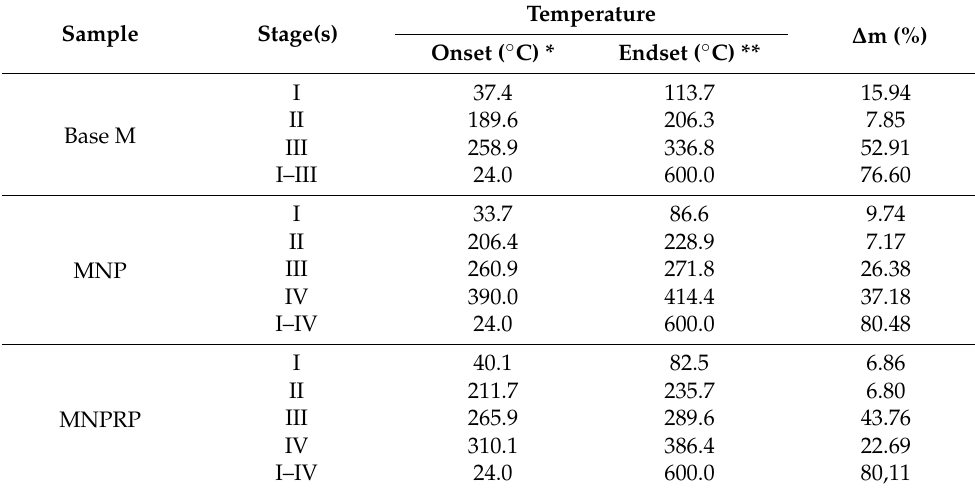
Table 6. Thermogravimetric events of Base M, MNP, and MNPRP.